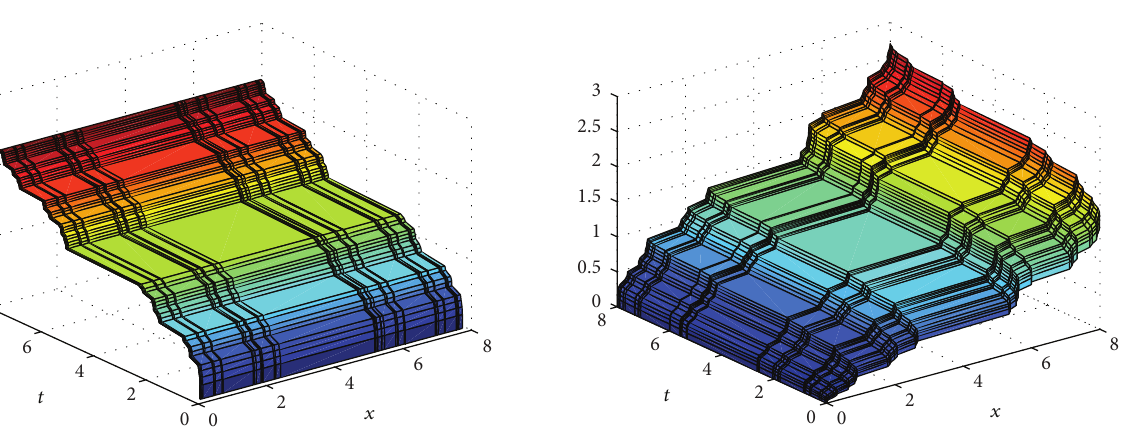
Figure 3: The surface shows the exact solution 𝑢(𝑥,𝑡) with a fixed value 𝛼 = ln 2/ ln 3